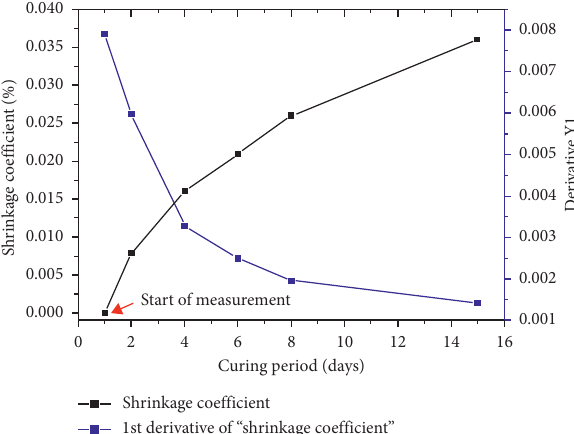
Figure 7: Shrinkage with different curing times.